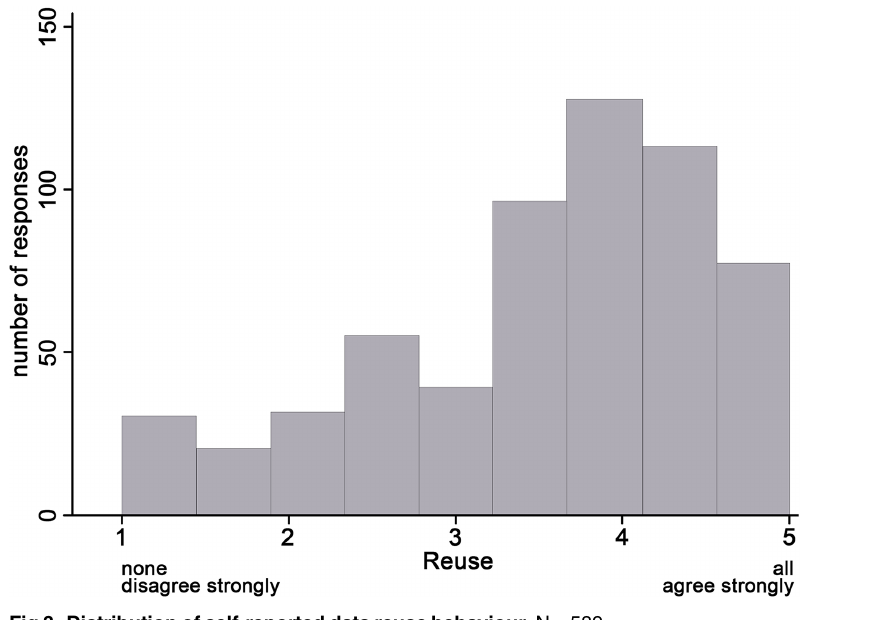
Fig 3. Distribution of self-reported data reuse behaviour. N = 589.